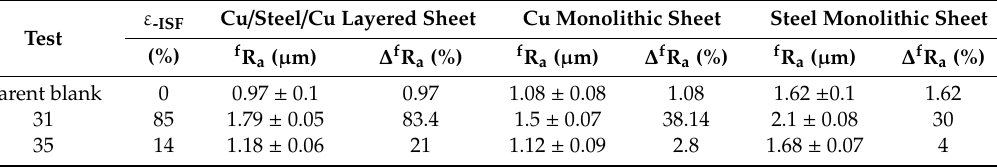
Table 4. Comparison of free-surface roughness in the layered and monolithic sheets.